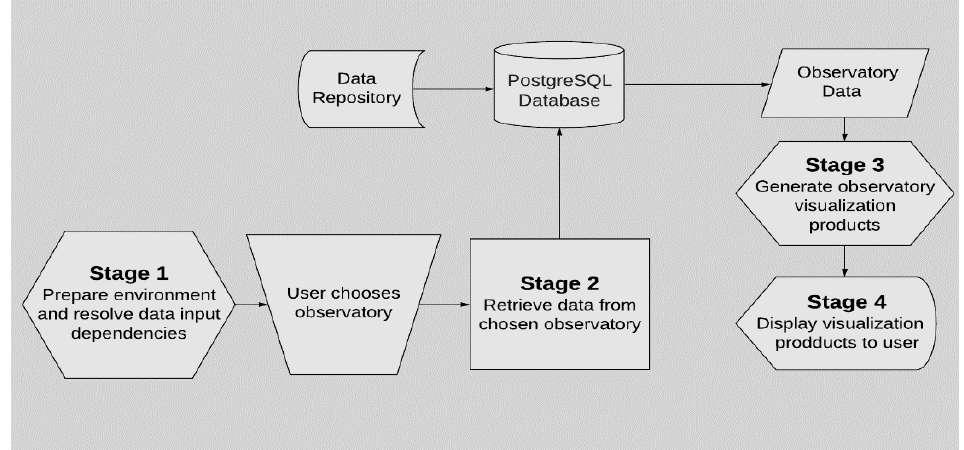
Figure 5. MOSAIC platform workflow.